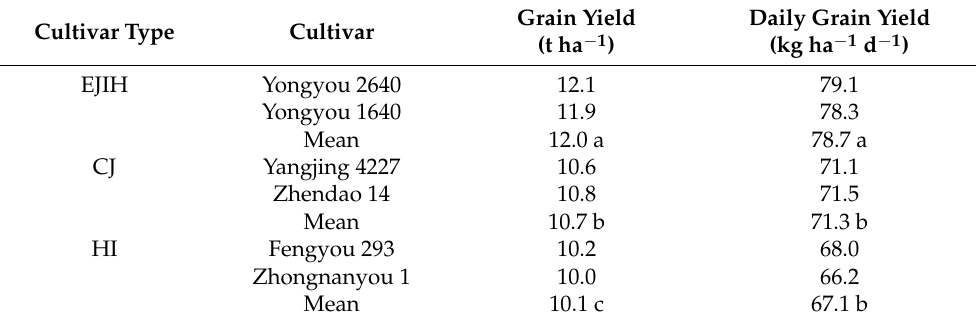
Table 3. Grain yield and daily grain yield of rice cultivars.